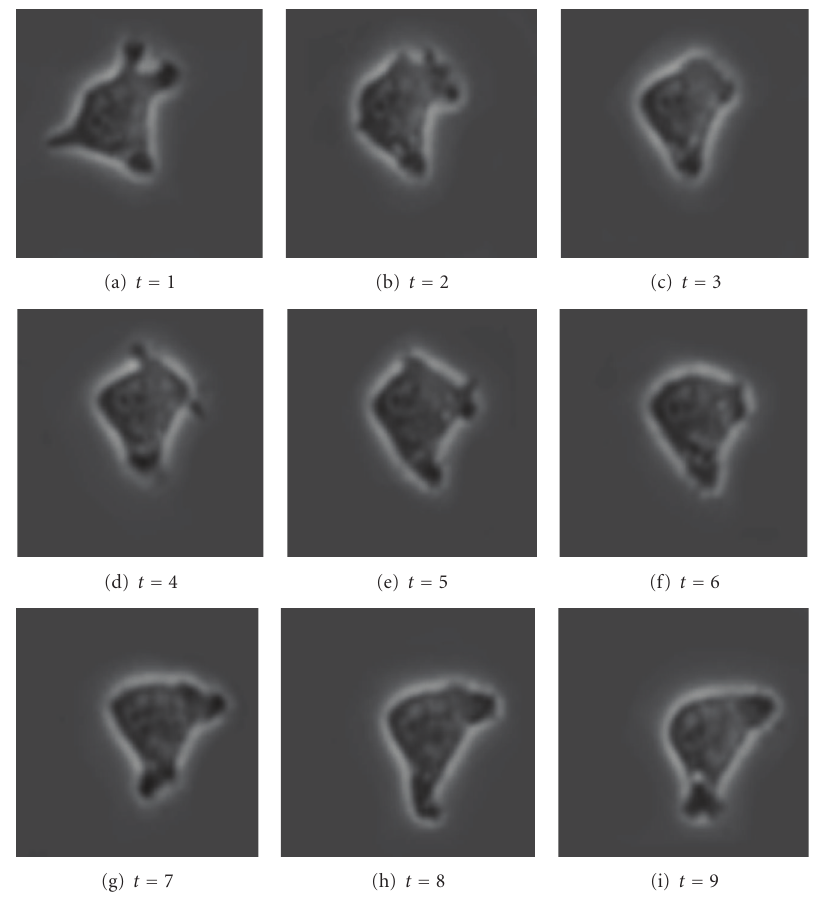
Figure 12: Original image